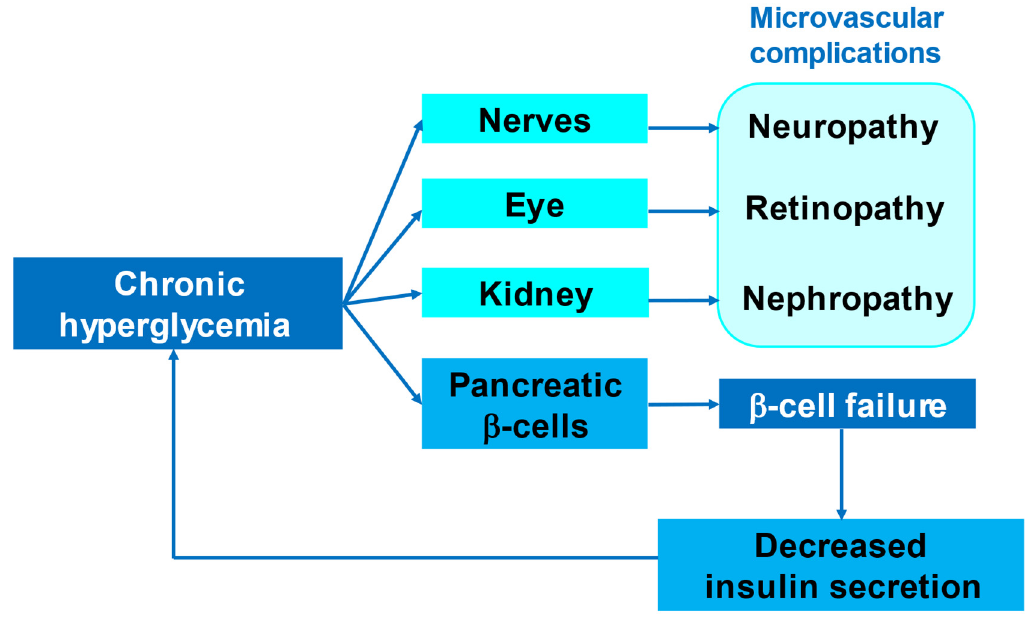
Figure 1. Target organs of the deleterious effects of chronic hyperglycemia.